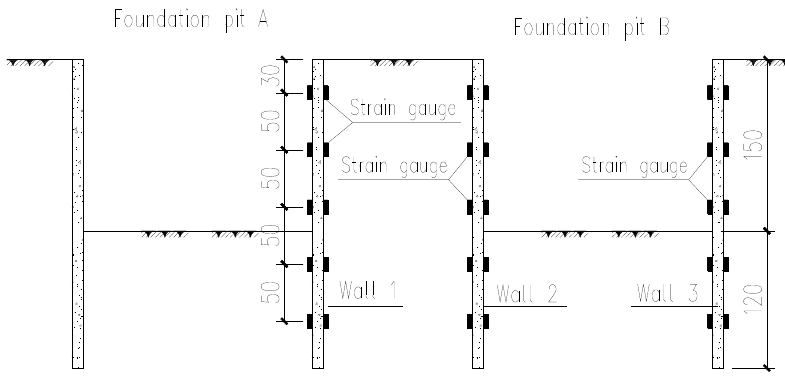
Figure 3. Layout diagram of the strain gauge.